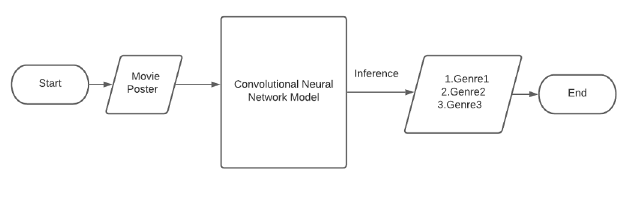
Fig. 1. Design of the system